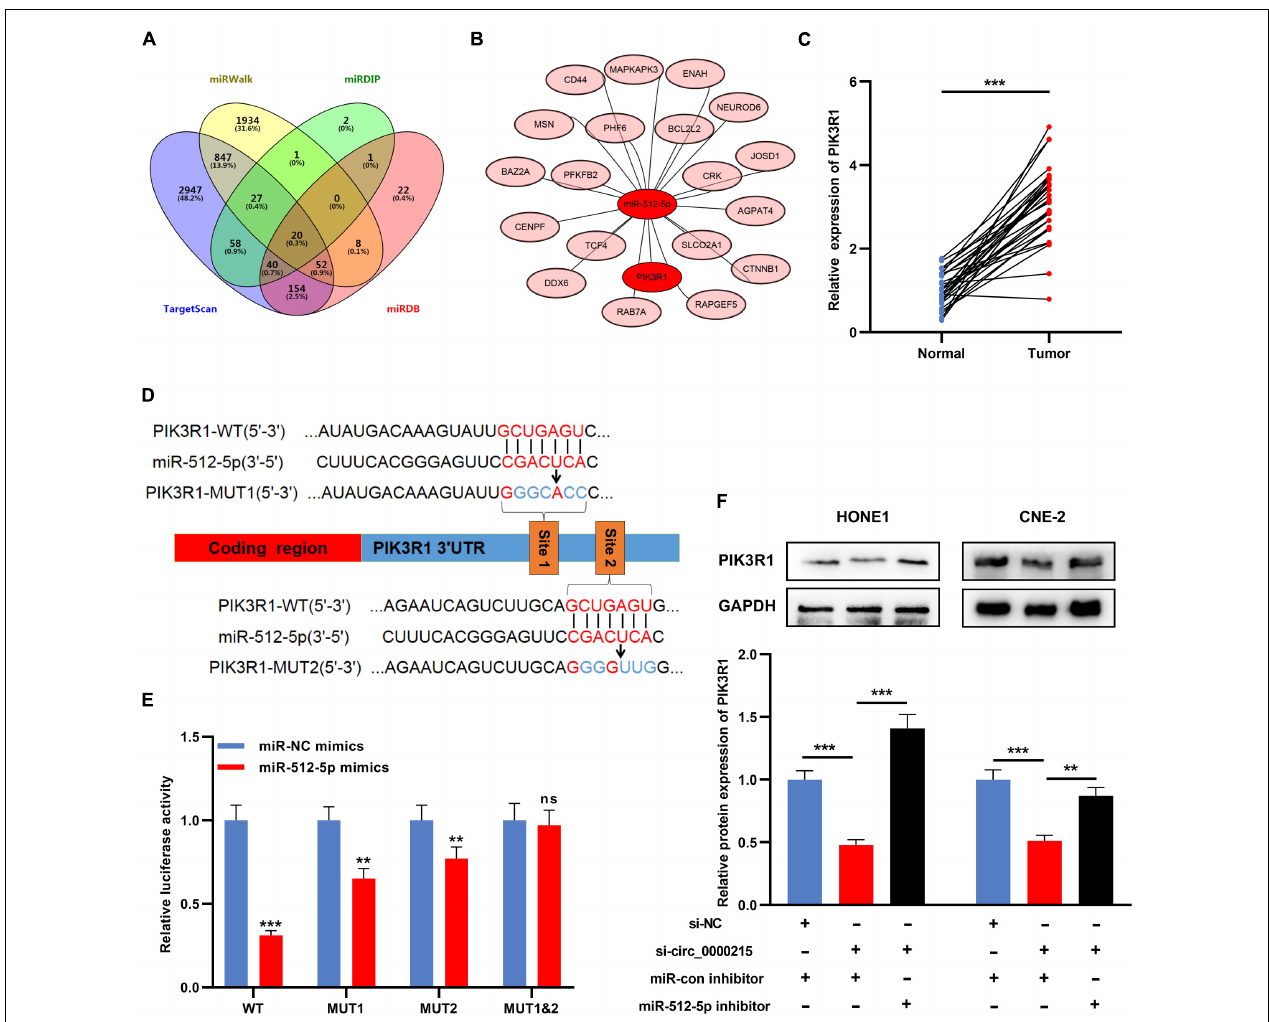
FIGURE 7 | Circ_0000215 modulates PIK3R1 through sponging miR-512-5p. (A) Venn diagram was employed to show the targets of miR-512-5p predicted by TargetScan, miRWalk, miRDB and mirDIP. (B) The schematic diagram showed the predicted targets of miR-512-5p. (C) qRT-PCR was performed to detect PIK3R1 expression in 32 pairs of NPC tissues and normal tissues adjacent to cancer. (D) The schematic diagram showed the binding sites between miR-512-5p and PIK3R1 3 (cid:48) UTR. (E) Dual-luciferase reporter gene assay was performed to validate the binding sites between miR-512-5p and PIK3R1 3 (cid:48) UTR. (F) Western blot was utilized to detect the effects of circ_0000215 and miR-512-5p on PIK3R1 expression in HONE1 and CNE-2 cells. The significance of difference was determined by Student’s t -test or one-way ANOVA.** P < 0.01, and *** P < 0.001, ns differences were not statistically significant. Data from three independent experiments were expressed as mean ± standard